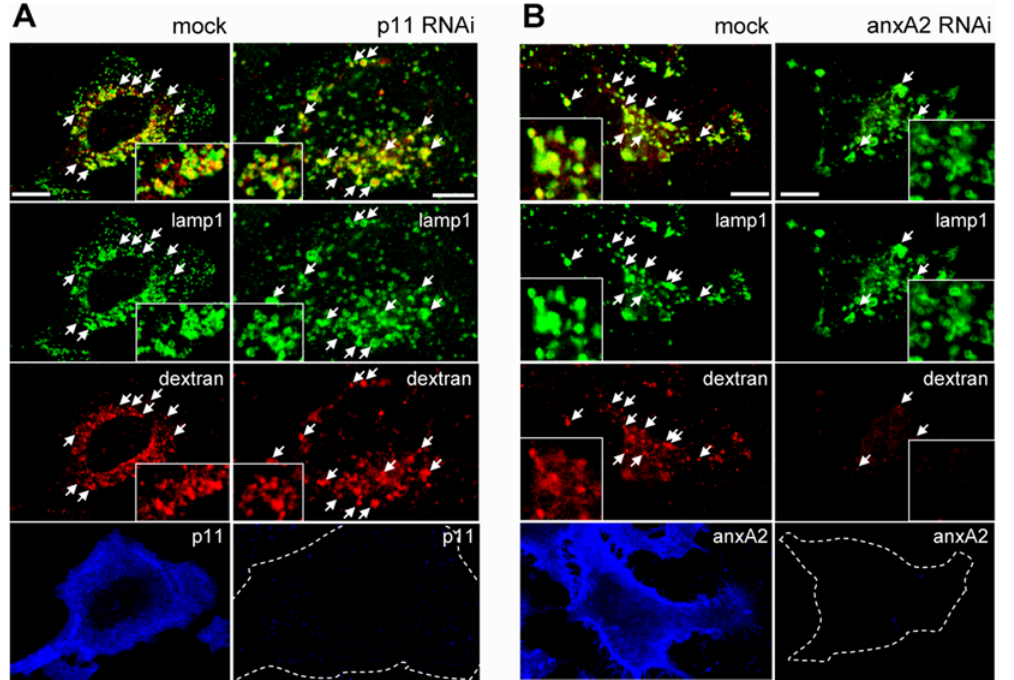
Figure 6. p11 downregulation does not alter transport from early to late endosomes. Rhodamin-dextran was endocytosed for 10 min at 37 u C and then chased for 40 min in marker-free medium, after p11 knockdown as in Fig 5 (left panels, with the corresponding mock-treatment on the left) or AnxA2 knockdown as in Fig 5 (right panels, with the corresponding mock-treatment on the left). Cells were then processed for immunofluorescence using the indicated antibodies as in Fig 1. Bar: 10 m m.